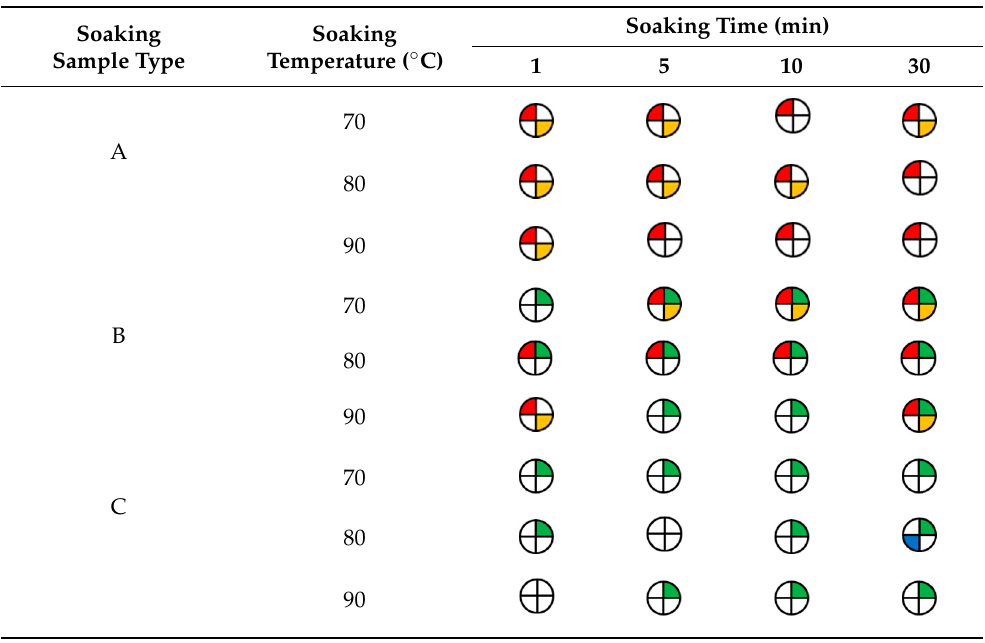
Table 1. Results of simultaneous identification of various MPs released from different filter bags soaked under different